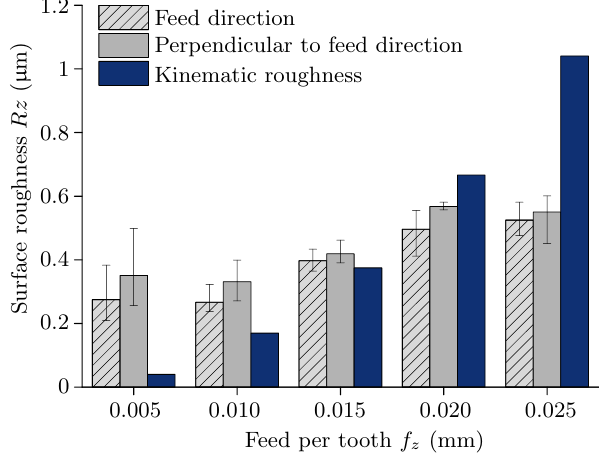
Figure 3. Surface roughness values Rz after machining with CVD diamond-tipped tools using different values of the feed per tooth according to